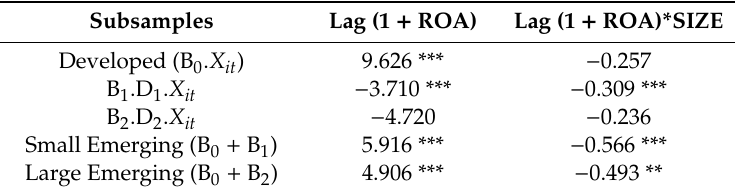
Table 7. E ff ect of lagged profitability and interaction term (lagged profitability*bank size) on economic growth.